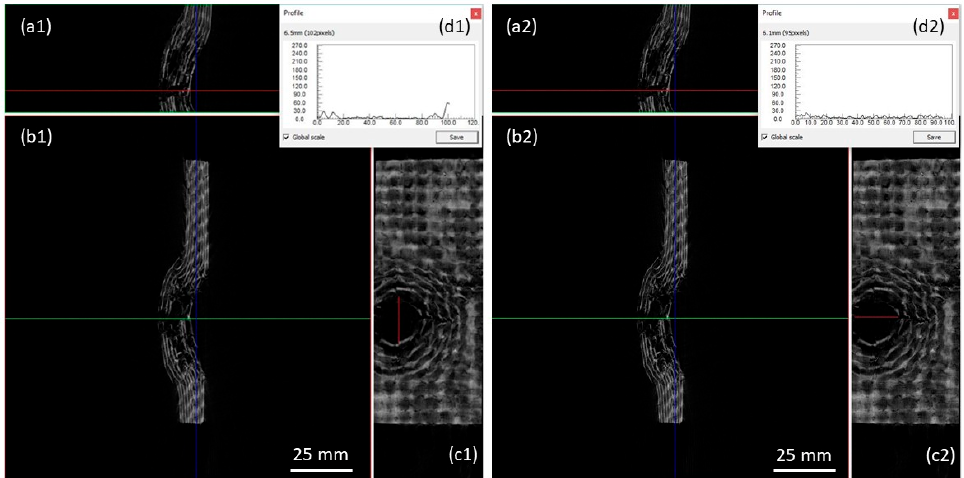
Figure 5. Three dimensional (3D) image after impact test of carbon fiber reinforced geopolymer composite. The part shows the area of impact.